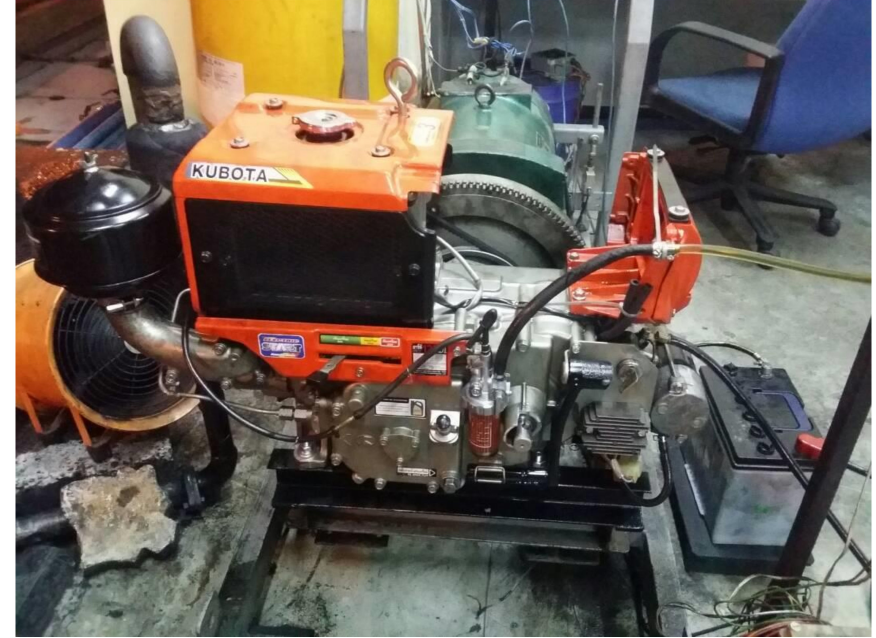
Figure 2. Kubota RT-125 diesel engine experimental setup. The engine load absorber (KAMA, Fuzhou, China) is based on the 7.5 kW A.C. syn- chronous dynamometer. It is used to provide loading to the engine and to maintain the engine speed. The fuel flow rate was measured with a DOM-A05H flow meter connected to a ZOD-Z3 flow rate totalizer (Kobold, Nordring, Germany). BOSCH BEA 150 is used to analyze the exhaust emissions from the engine such as CO, CO 2 , HC, and NO as shown in Figure 3. The measurement range and accuracy of instrument used are given in Table 2. Smoke analyzer (BOSCH, Gerlingen, Germany) was used to collect smoke samples from the engine, through smoke sampling sensor to measure smoke opacity.